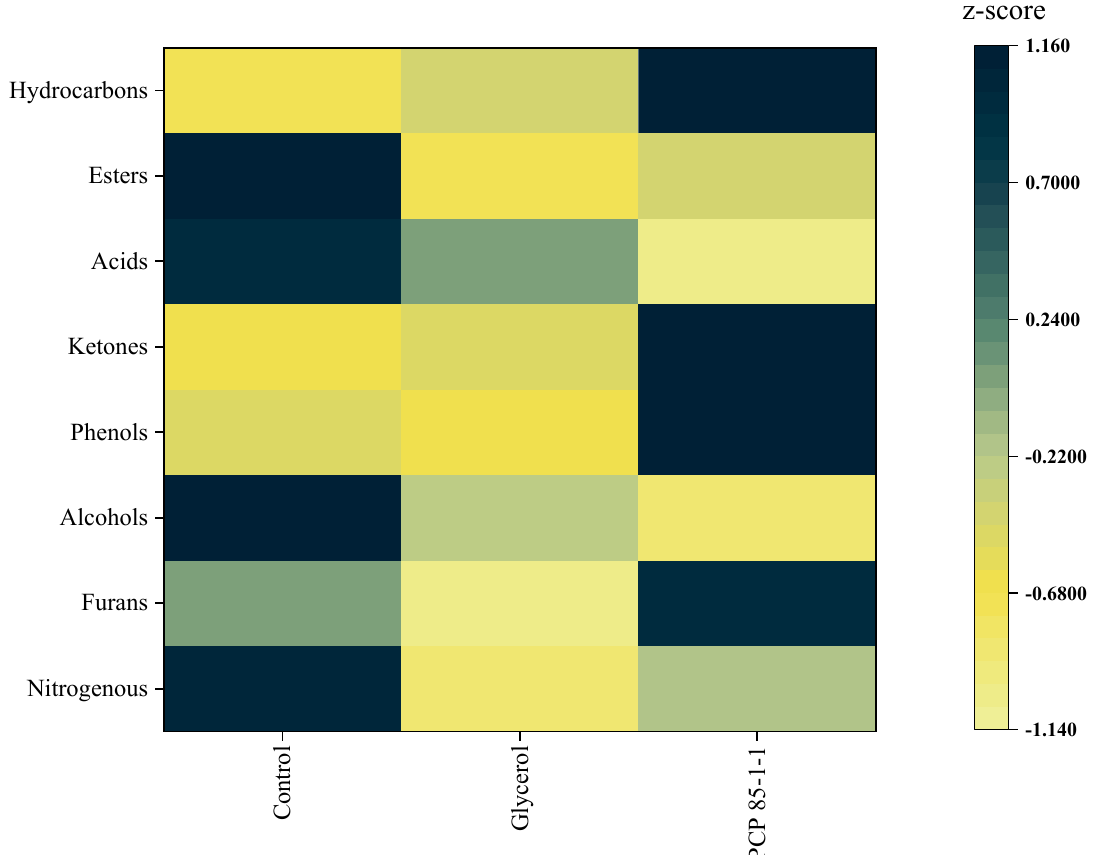
Figure 7. Hot map of the kinds of volatile compounds in the extract of tobacco shreds after